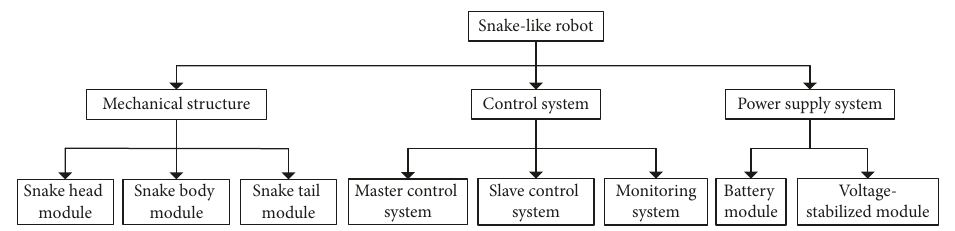
Figure 1: Design diagram of the overall scheme.